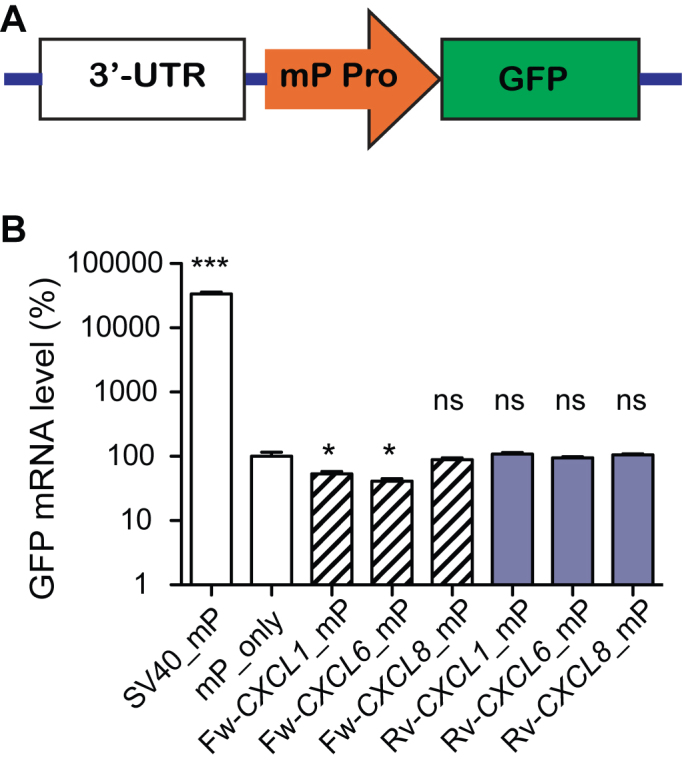
Chemokine 3′-UTR DNA effects on gene expression in an enhancer reporter. (A) Diagram of the enhancer reporter. mP Pro is a minimal CMV promoter. (B) Chemokine 3′-UTR DNA effects on reporter mRNA. A construct with the minimal promoter but no enhancer sequence (mP_only) served as a negative control; SV40 served as a positive control enhancer. *P < 0.05, ***P < 0.001, n.s., no significant difference by one-way ANOVA and Dunnett’s test, n = 5.